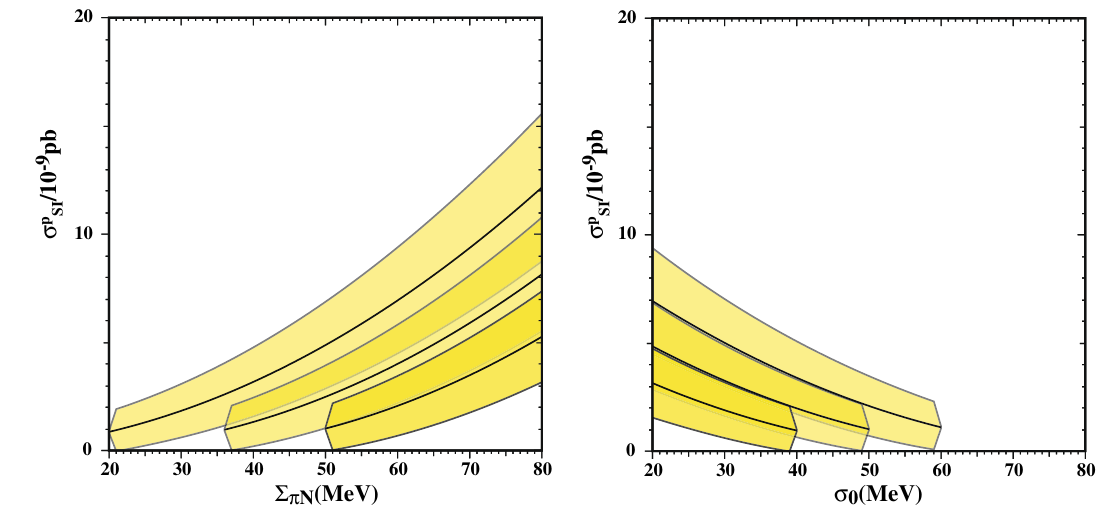
Fig. 1 Left: σ p vs (cid:7) π N for σ 0 = 20 , 36 , 50 MeV. Right: σ p SI elastic cross section calculated using the three-flavour expression (5)